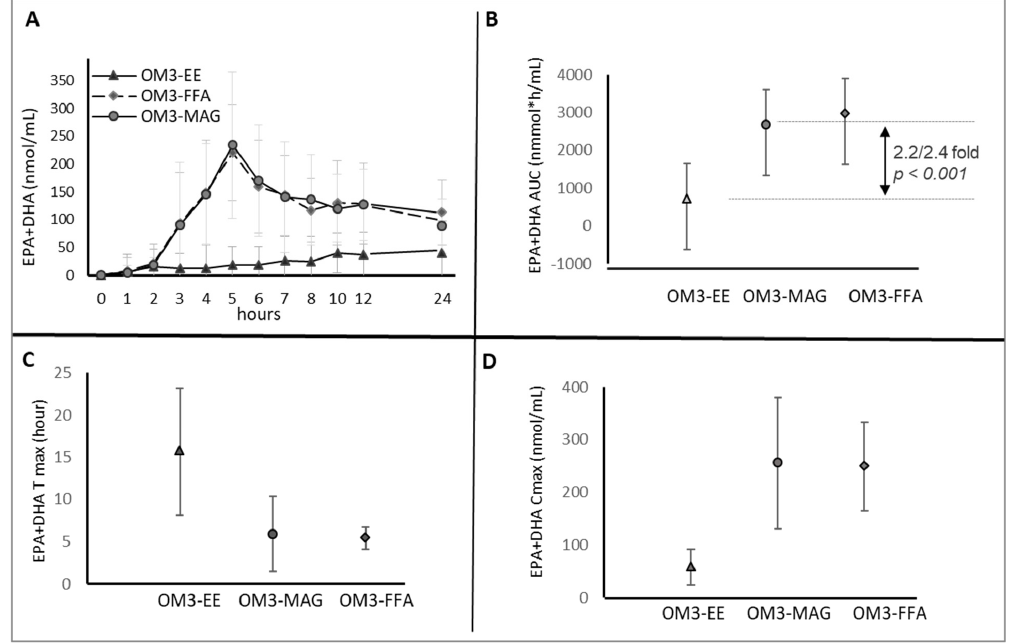
Figure 4. Clinical trial A. Acute effect: Pharmacokinetic results (baseline-adjusted), EPA + DHA in Plasma, AUC over 24 h postprandial (upper panel ( A , B )). Results are expressed in nmol · h / mL. Tmax (hour) and C max (nmol / mL), lower panel ( C , D